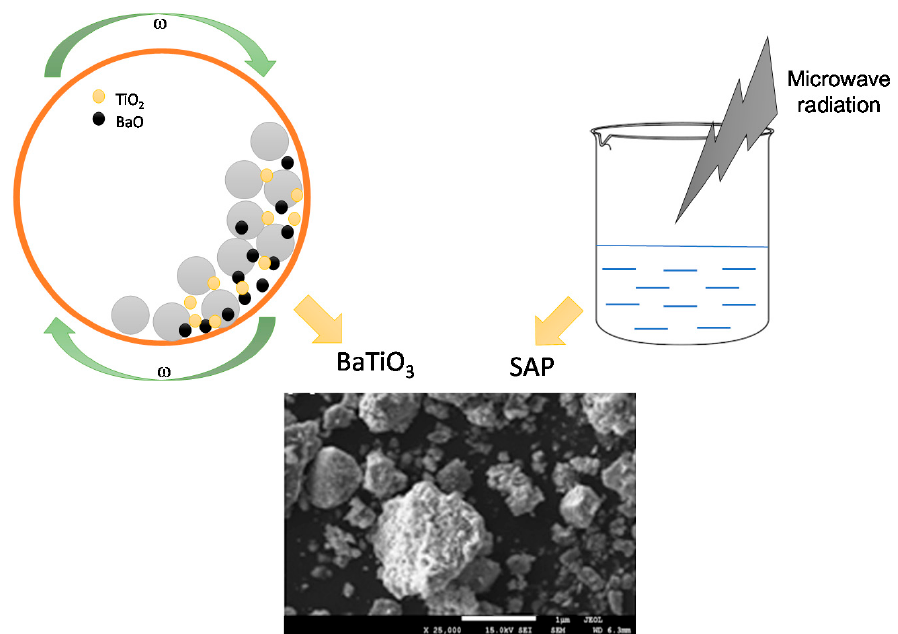
Figure 2. The scheme of the preparation of the dispersion of BaTiO 3 stabilized by superabsorbent polymer suspension (SAP).